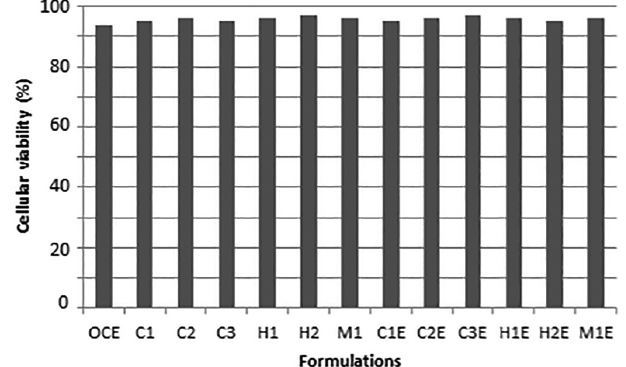
FIGURE 6 - Cellular viability (%) to OCE free, OCE-unloaded and -loaded